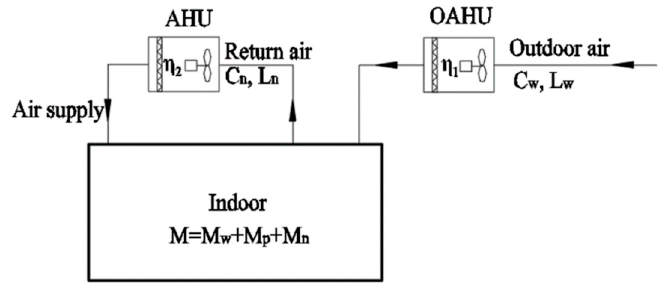
Figure 10. Schematic diagram of a semi-centralized system with outdoor air pretreatment.